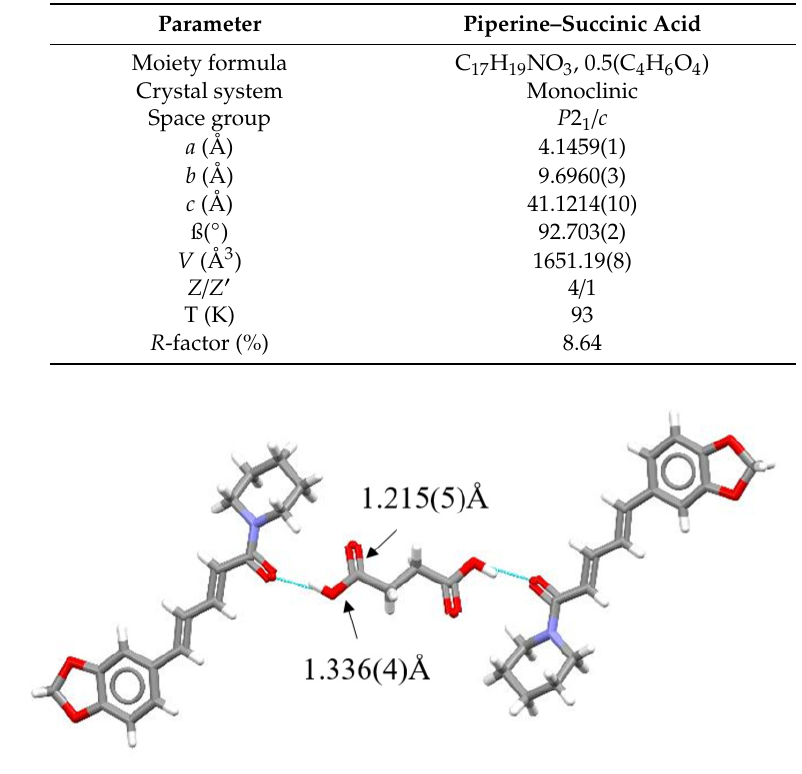
Figure 5. Dissolution rate profile of piperine (blue), physical mixture (grey), and the cocrystal (orange). In the current study, we reported the novel cocrystal of piperine–succinic acid (2:1 molar ratio), which improved the solubility and dissolution rate, as shown in Table 2 and Figure 6. The solubility of the cocrystal increased approximately 4-fold compared with that of intact piperine. Consequently, the dissolution rate of the cocrystal also improved significantly. According to the Noyes–Whitney equation, the dissolution rate of the solid is proportional to its solubility [53]. Furthermore, the cocrystal of piperine–succinic acid showed a faster dissolution rate than that of intact piperine. The percentage of piperine dissolved from the cocrystal significantly improved compared to that of intact piperine and its physical mixture. In 60 min, 99.00% of piperine dissolved from the cocrystal, whereas only 45.30 and 62.22 % of intact piperine and physical mixture dissolved, respectively. The dissolution rate of the physical mixture of piperine–succinic acid increased slightly compared to